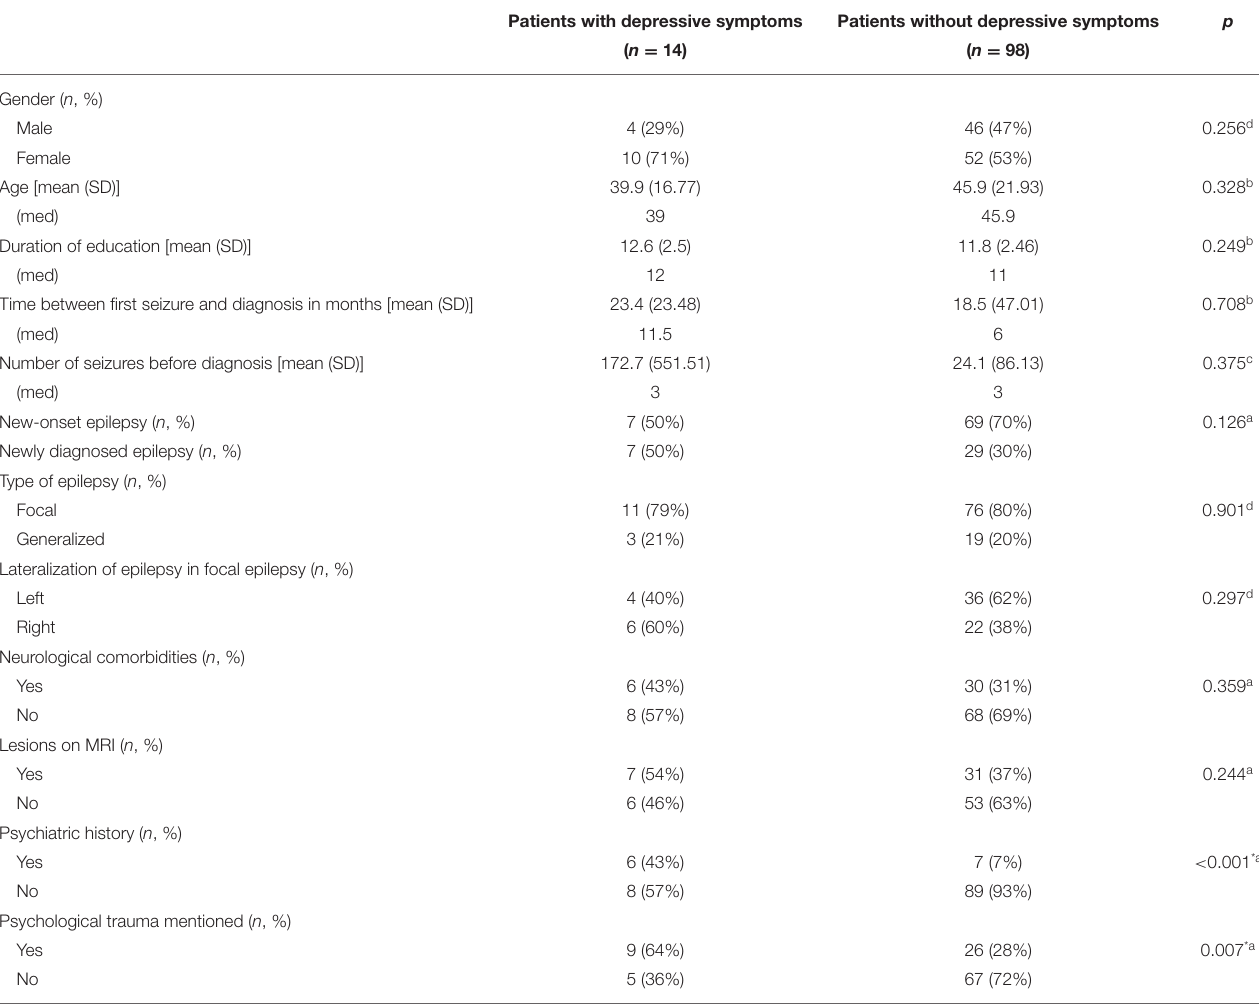
TABLE 3 | Sociodemographic and medical data according to the presence or absence of depressive symptoms. Patients with depressive symptoms Patients without depressive